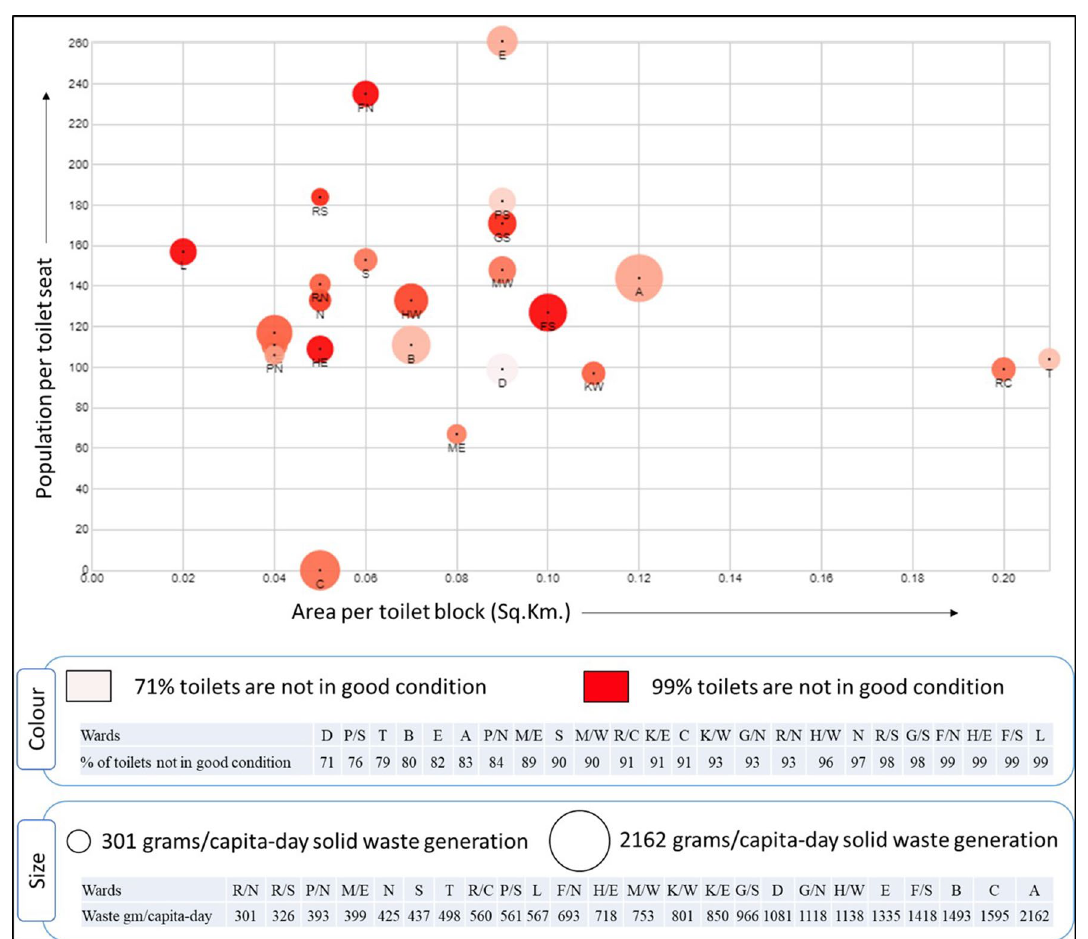
Fig. 1 Wardwise sanitation status in